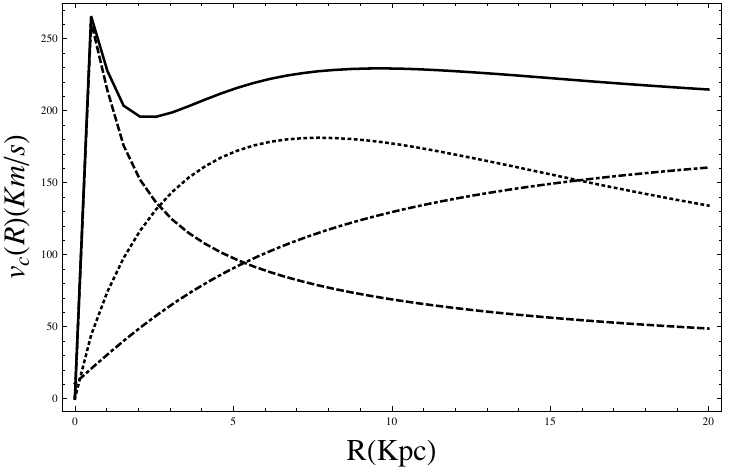
Figure 5. Comparison between the rotation curves of galactic components: bulge (dashed line), disk (dotted line), DM (dotted and dashed line) and the global galactic rotation curve (solid line). All curves have been valuated in the framework of FOG + DM.